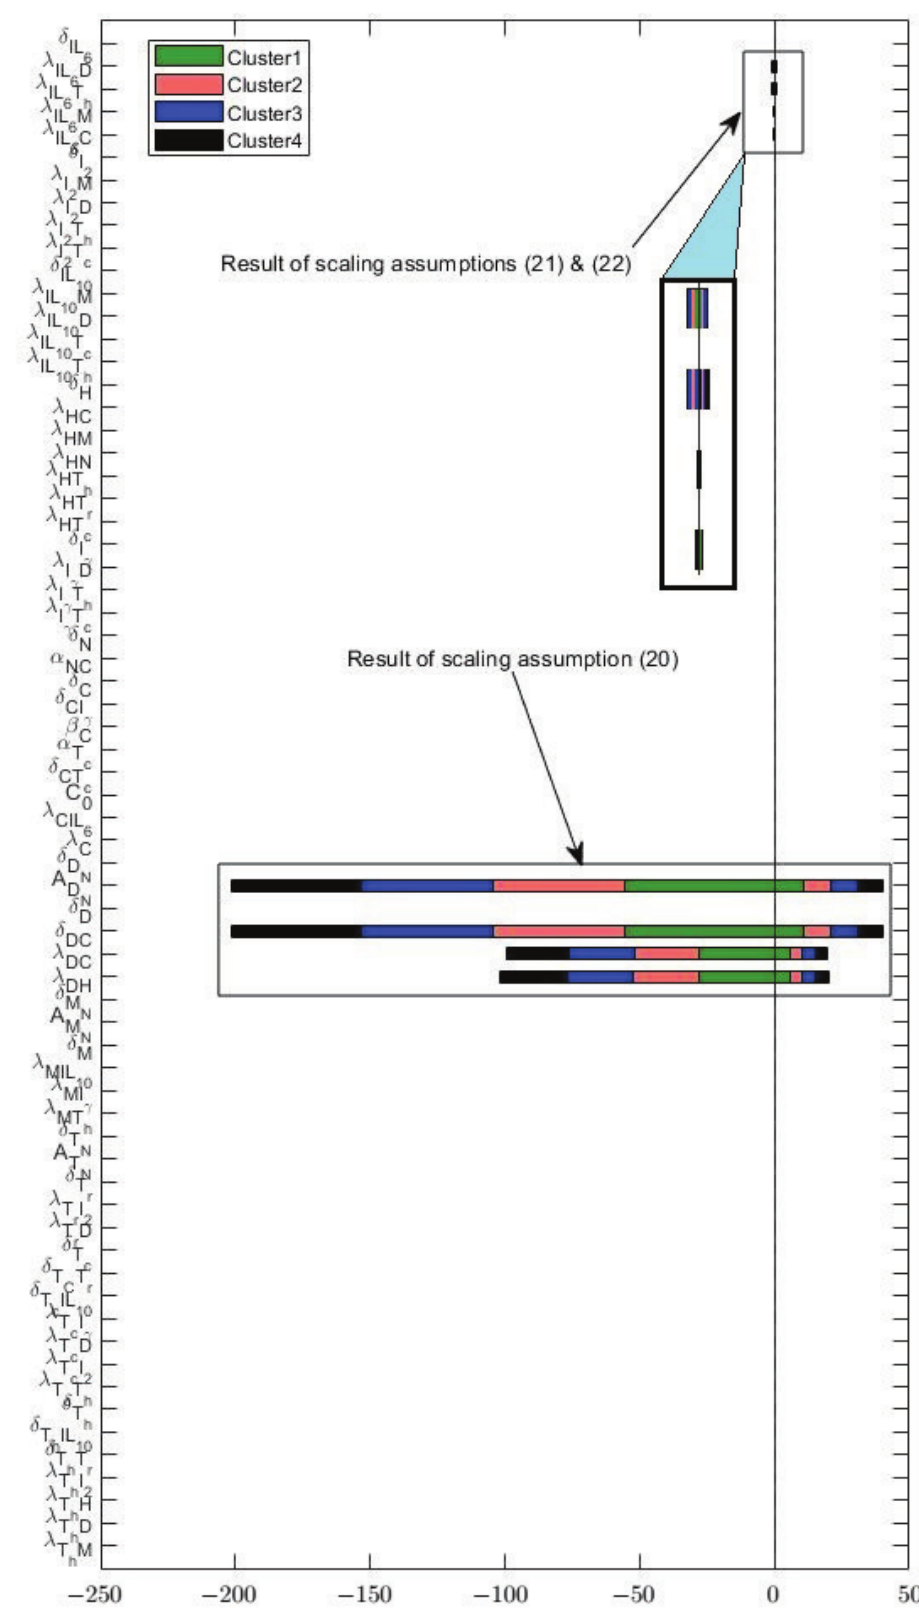
Figure 6. Deviations in parameter values from their baseline due to scaling assumptions